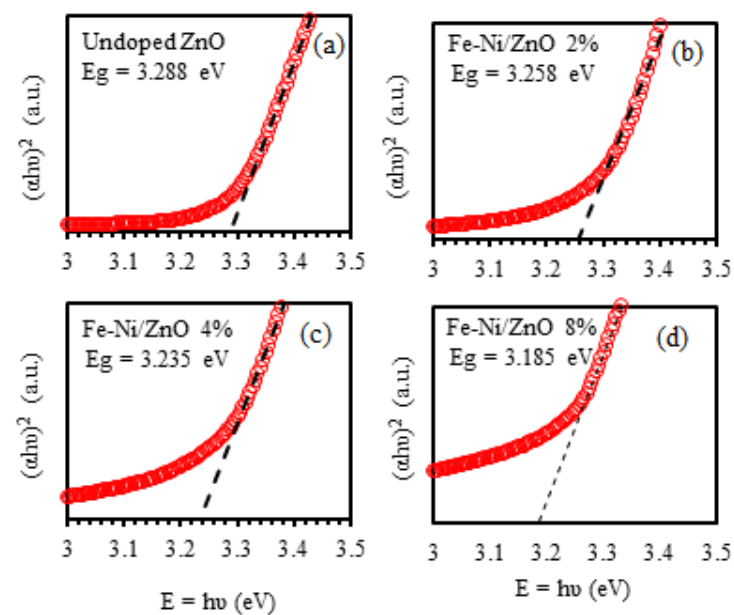
Figure 9. Tauc E g of ( a ) undoped ZnO, ( b ) 2%, ( c ) 4% and ( d ) 8% of Fe-Ni co-doped ZnO thin films.